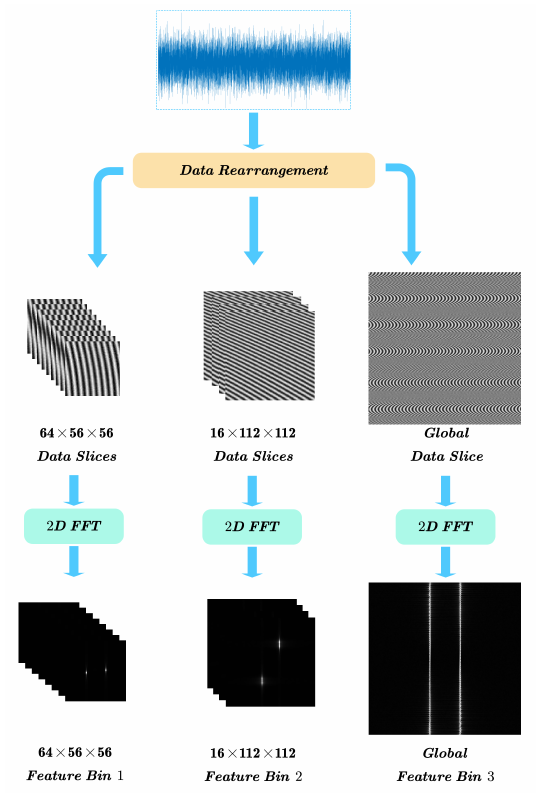
Figure 8. DR2D preprocessing of the radiation source